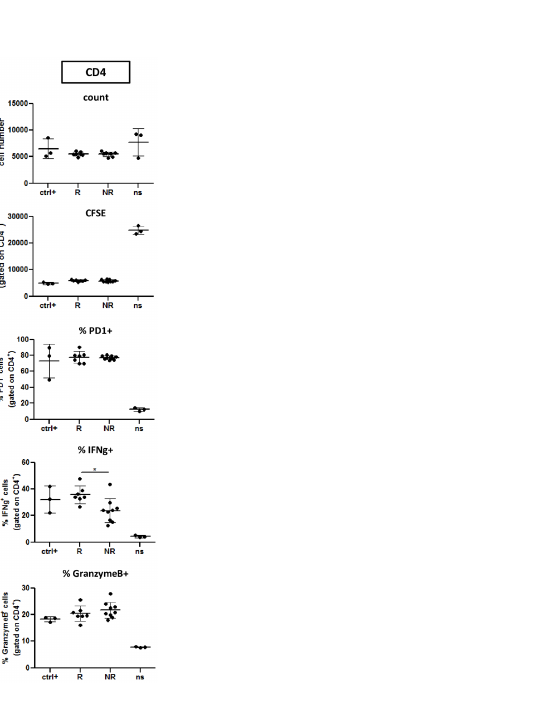
FIGURE 4 R-EVs and NR-EVs do not affect T cell proliferation and activation. CFSE labeled CD8 + and CD4 + T cells isolated from healthy donor PBMCs were primed in vitro with CD3/CD28, either alone (Ctrl+) or in presence of EV from Responder (R) or non responder patients (NR). Negative control T cells were left not stimulated (ns). Histograms show absolute numbers of CD8+ and CD4+ lymphocytes and proliferation (measured as CFSE dilution) and percentage of IFN g + , PD1 + , and Granzyme B + cells within either CD8+ or CD4+ T cells. *p<0.05; **p<0.01; ns, not